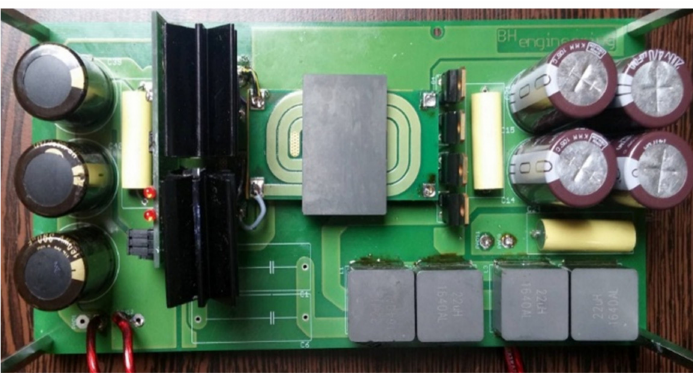
Figure 6. Experimental prototype of perspective MPPT converter.